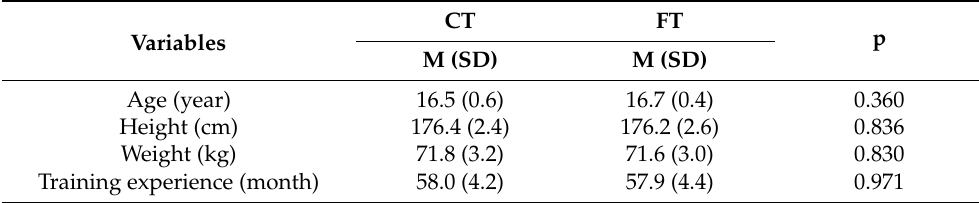
Table 1. Participants’ demographics.